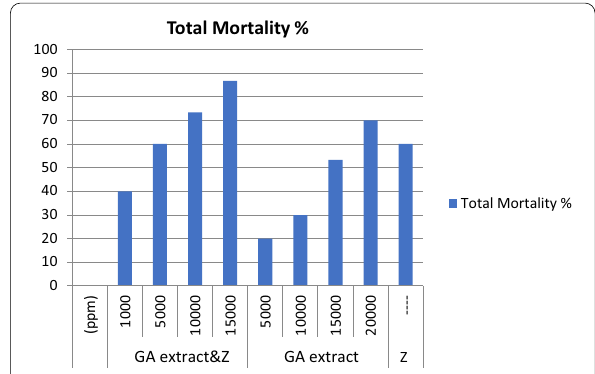
Fig. 1 Total mortality % of P. solenopsis treated with Zamzam water ( Z ), globe artichoke extract with (GA extract & Z ) and